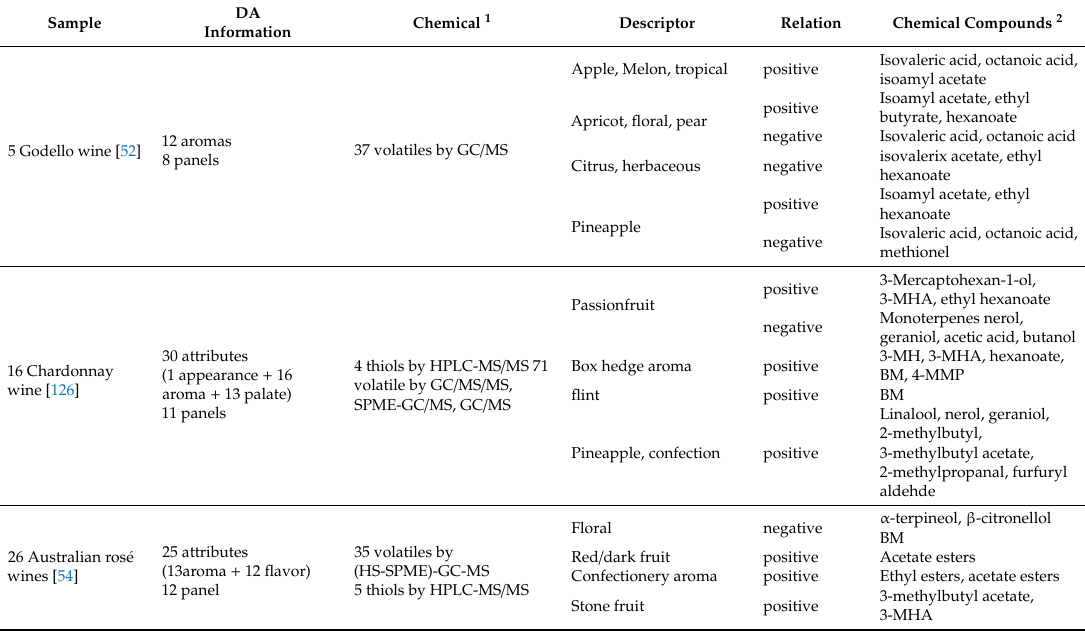
Study details and information of chemical analysis accompanied with descriptive sensory